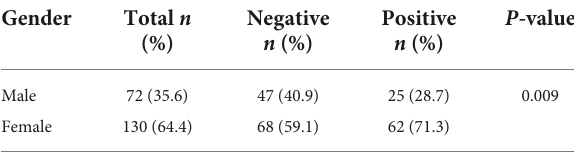
TABLE 1 Distribution of the human T-lymphotropic virus type 1 (HTLV-1) infection regarding